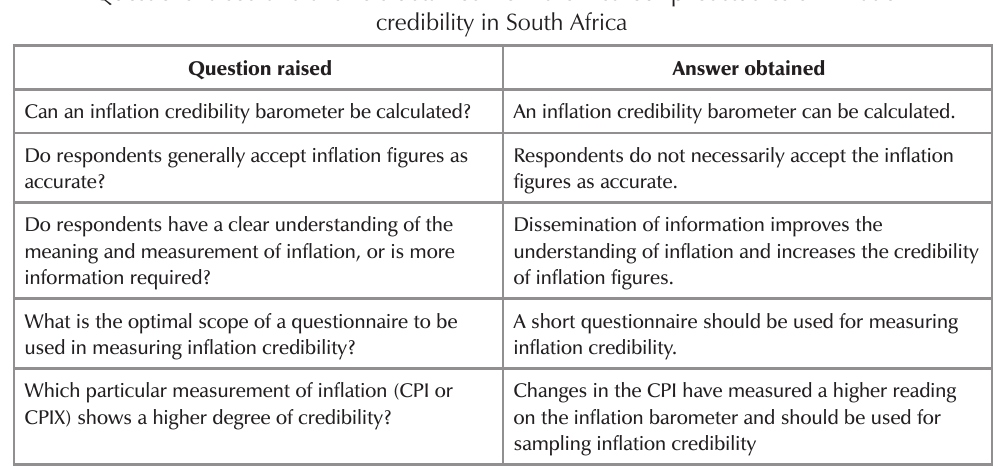
Questions raised and answers obtained from the first four pilot studies on